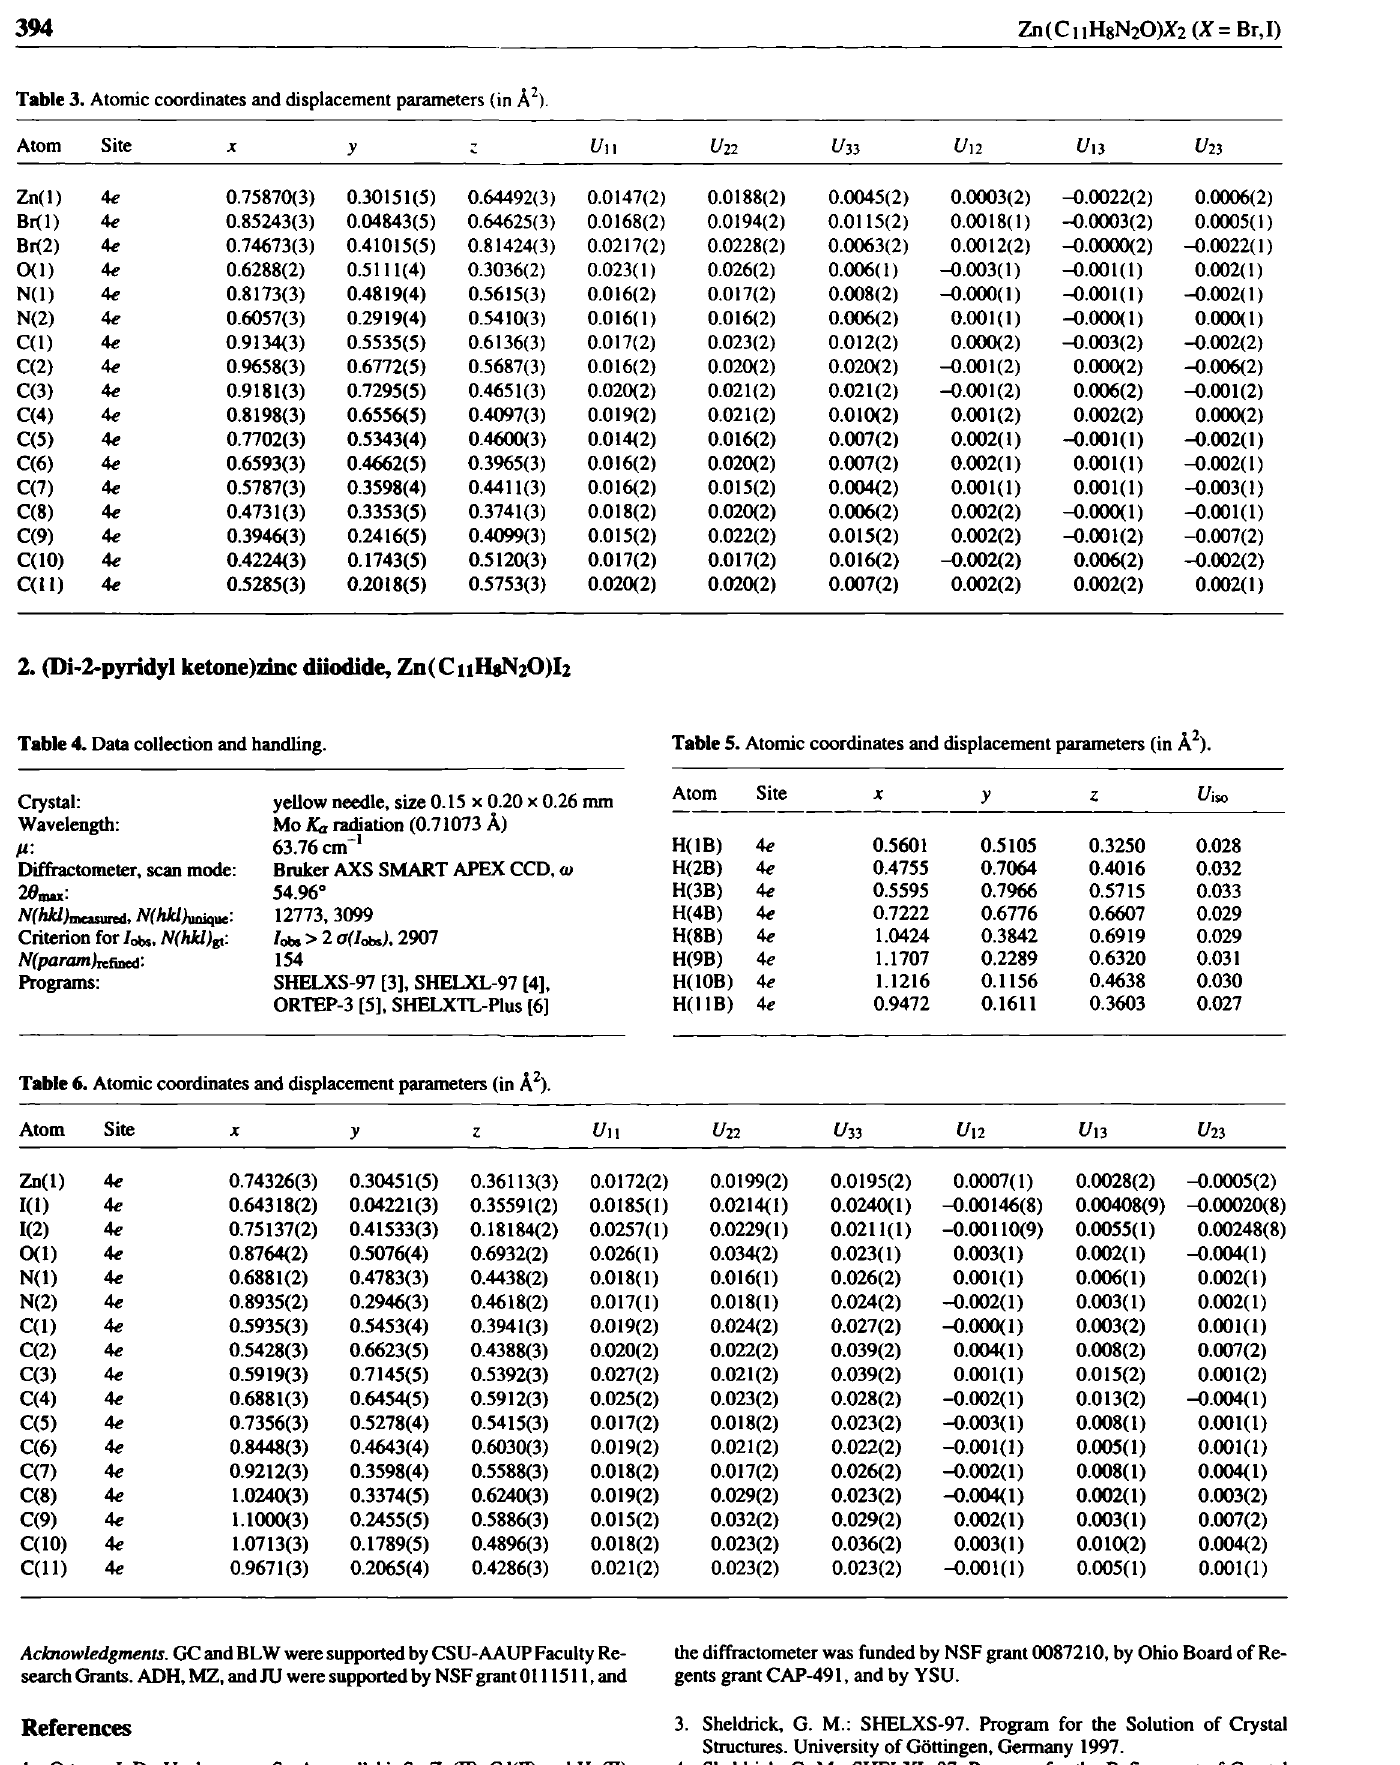
Table 3. Atomic coordinates and displacement parameters (in A 2 ).